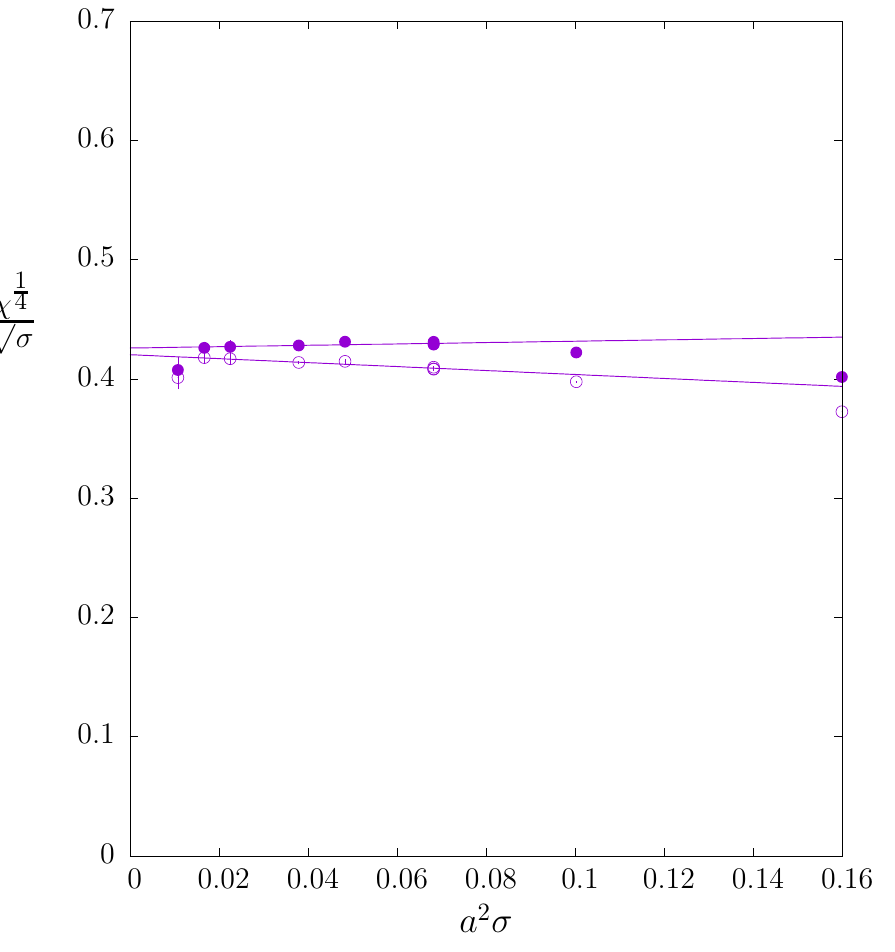
Figure 31 . Topological susceptibility in units of the string tension. Continuum extropolation using raw Q , ◦ , and integer valued Q , • , both after 20 cooling